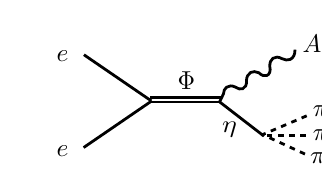
(cid:0) colliders: